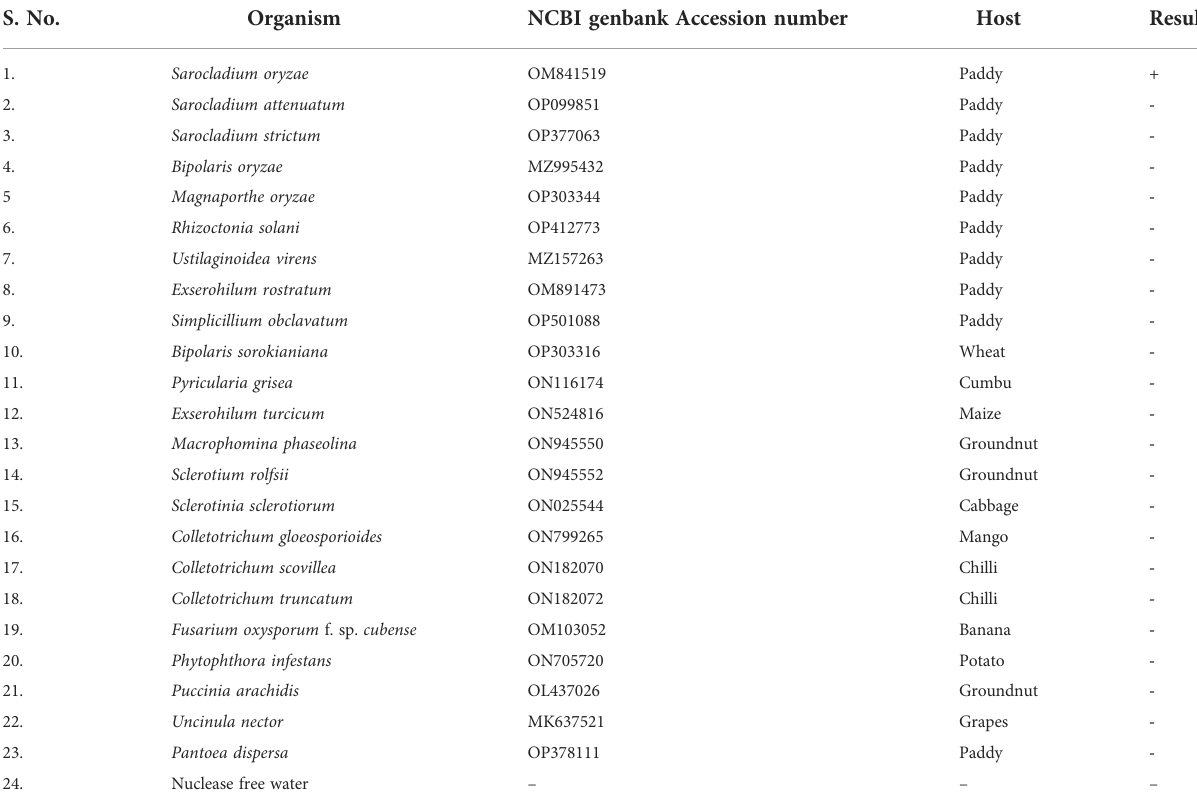
TABLE 4 Speci fi city of LAMP assay for the detection of S. oryzae targeting b -tubulin gene. S.